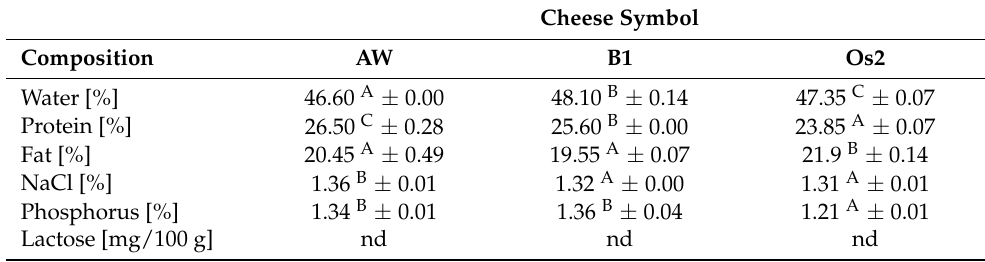
Table 2. The basic composition of acid-rennet goat’s cheeses directly after production.